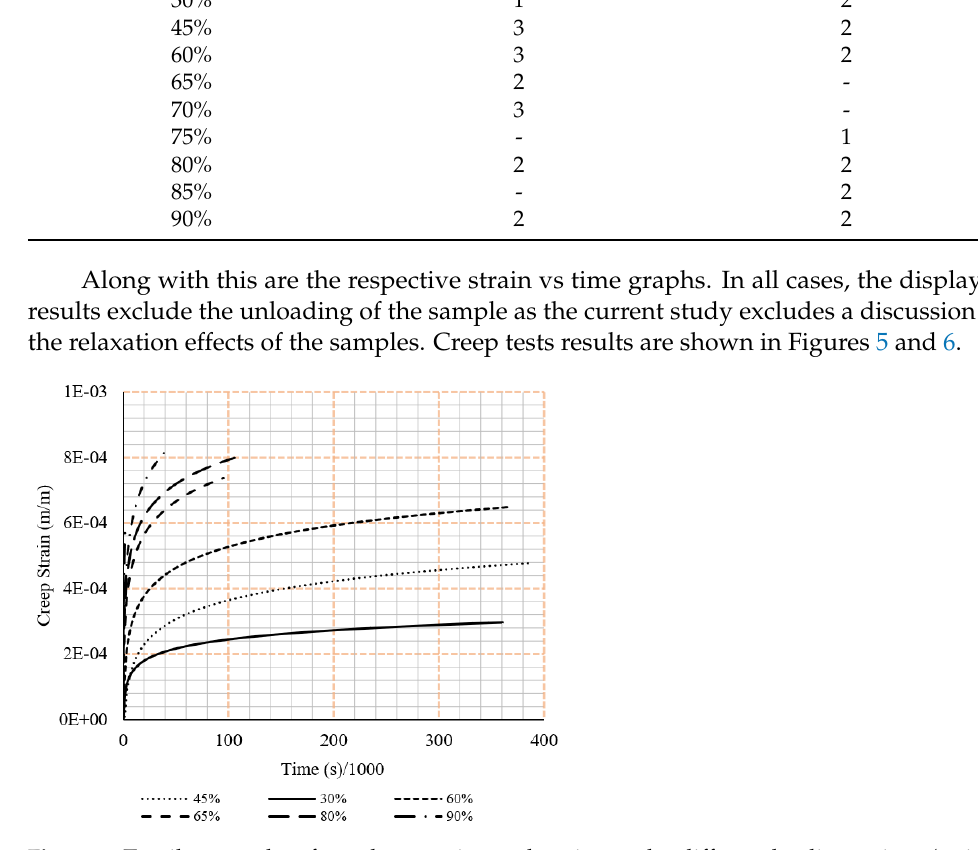
Figure 5. Tensile creep data from the experimental testing under different loading rations (ratio of sustained load to the ultimate load).